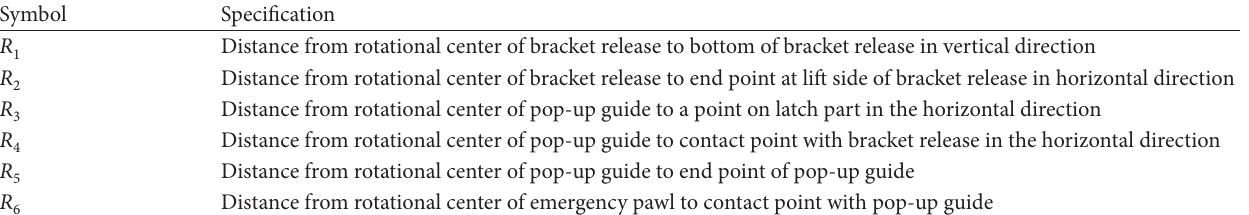
Table 4: Variables for entire distances.